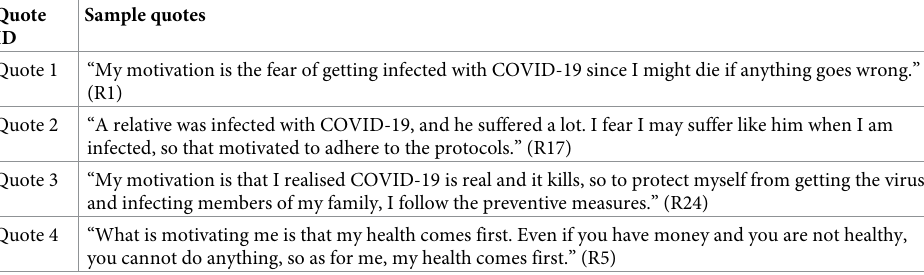
Table 3. Quotes on motivation to adhere to all COVID-19 preventive